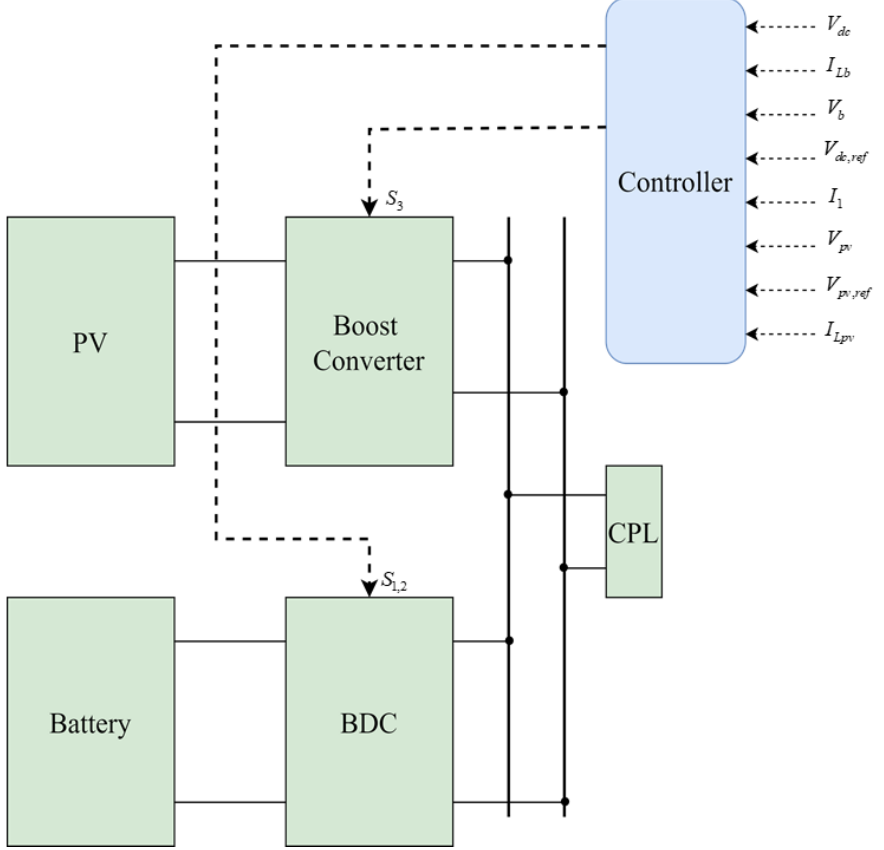
Figure 3. Overall block diagram of the system.